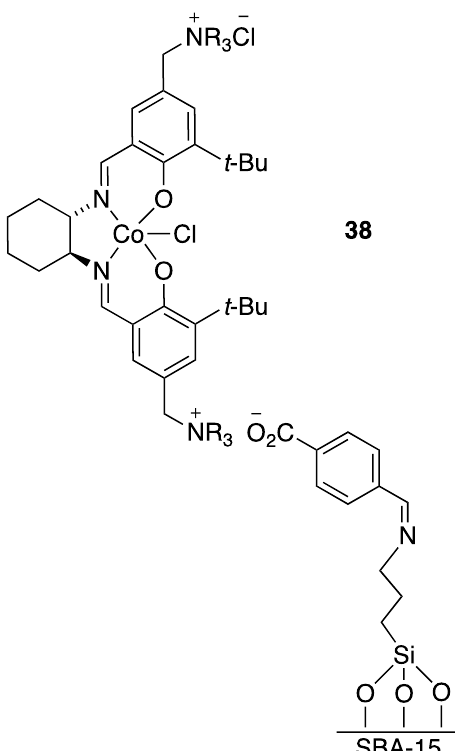
Figure 16. A Co–salen complex immobilized on mesoporous silica